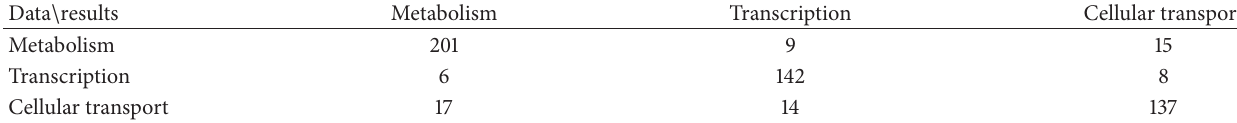
Table 7: Confusion matrix obtained using neural network classifier on dataset 1.